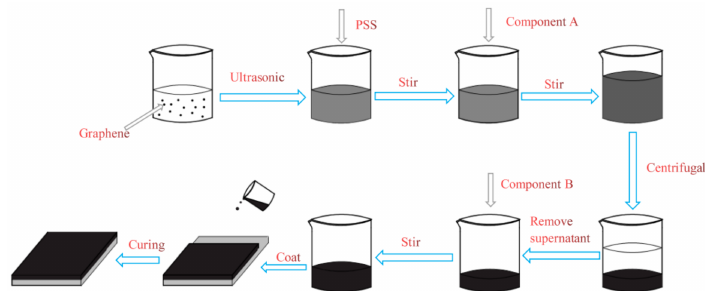
Figure 1. Schematic illustration of the preparation process of the composite